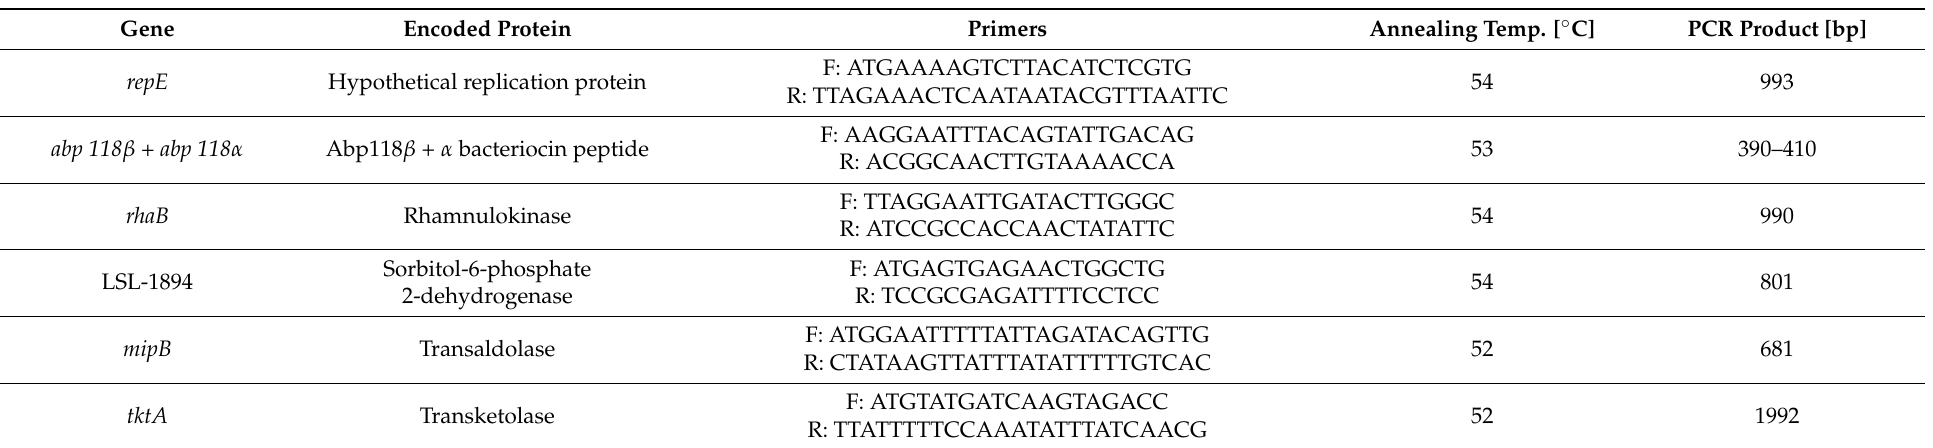
Table 1. Primers used in this